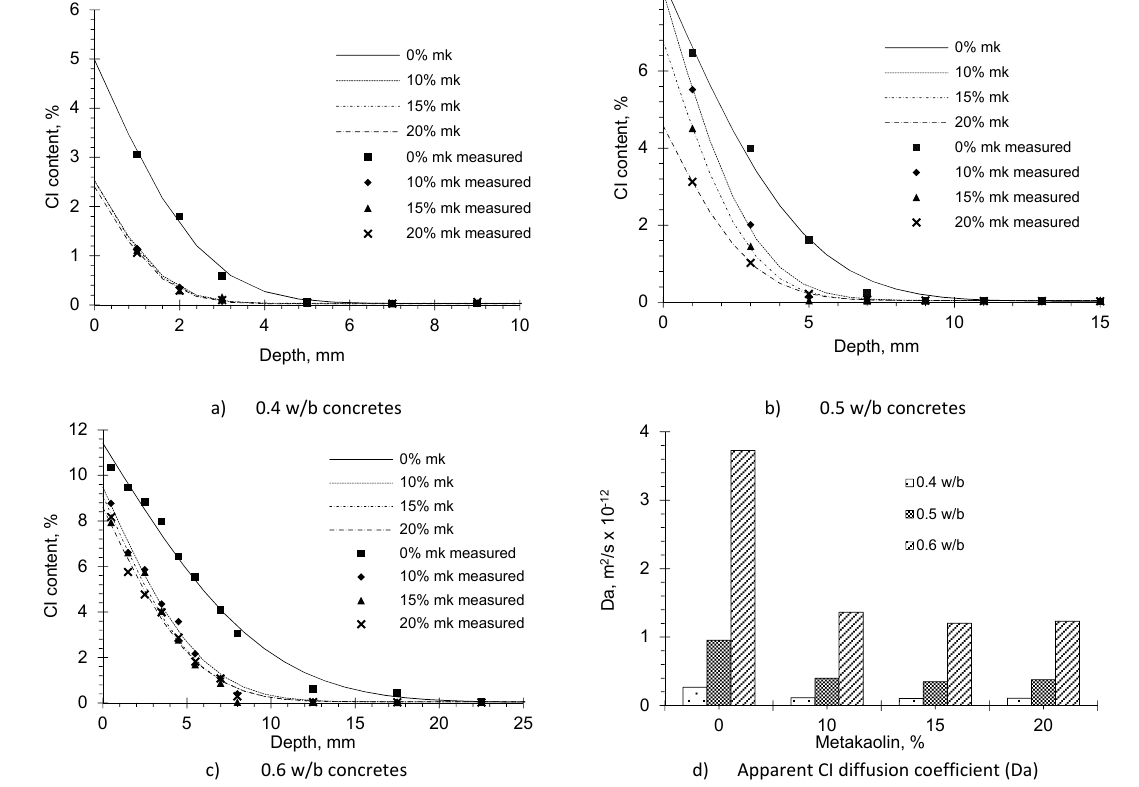
Figure 8. Carbonation depths of concrete at 0.5 and 0.6 w/b ratio, after 28, 56, and 90 days of accelerated carbonation.